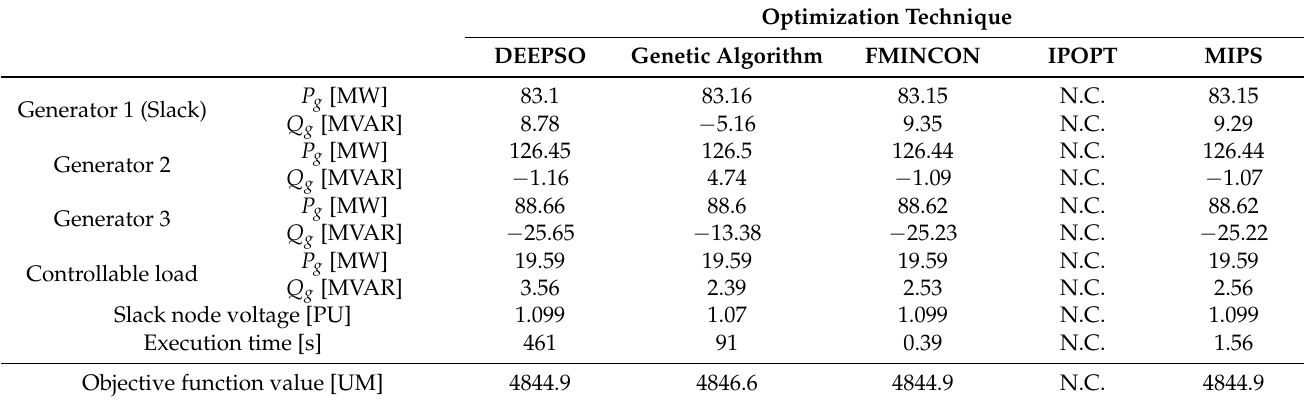
Table 8. Results obtained for the 9-node system in scenario